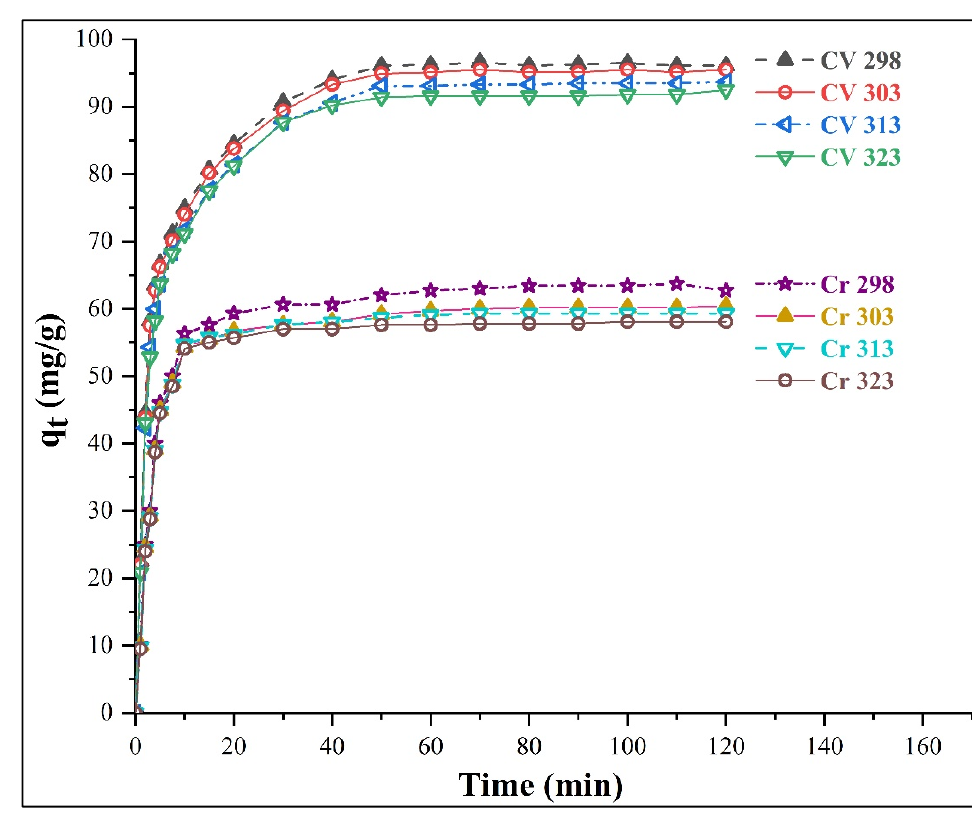
Figure 10. Effect of time and temperature on the adsorption of CV and Cr (VI) on ACSCGs. The rapid adsorption at the beginning is due to a large concentration gradient be- tween the solution and the adsorbate concentration on the solid surface, as well as the large number of important vacant adsorption active sites. The slow increase in the later stage is attributed to the low number of free sites. Regarding the effect of temperature, the decrease in the adsorbed amount of both pollutants with increasing temperature indicates that the adsorption is exothermic and is therefore more favourable at low temperatures.